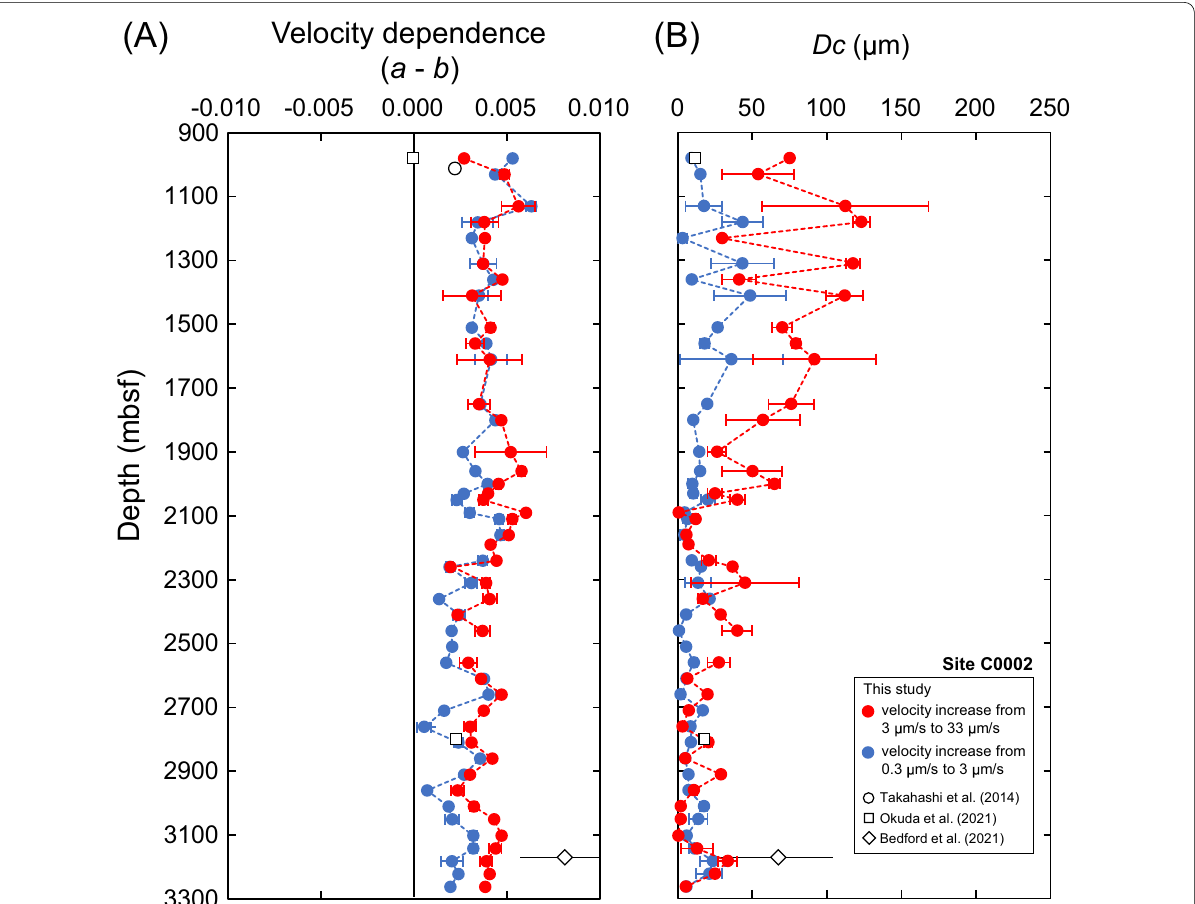
Fig. 6 Depth profiles of A the velocity dependence of friction a results for velocity change from 3 to 33 μm/s and from 0.3 to 3 μm/s, respectively. The error bars are estimated from the variations in the repeated tests. Open circles, squares, and diamond indicate data from previous studies at Site C0002 (Takahashi et al. 2014; Okuda et al. 2021; Bedford et al.